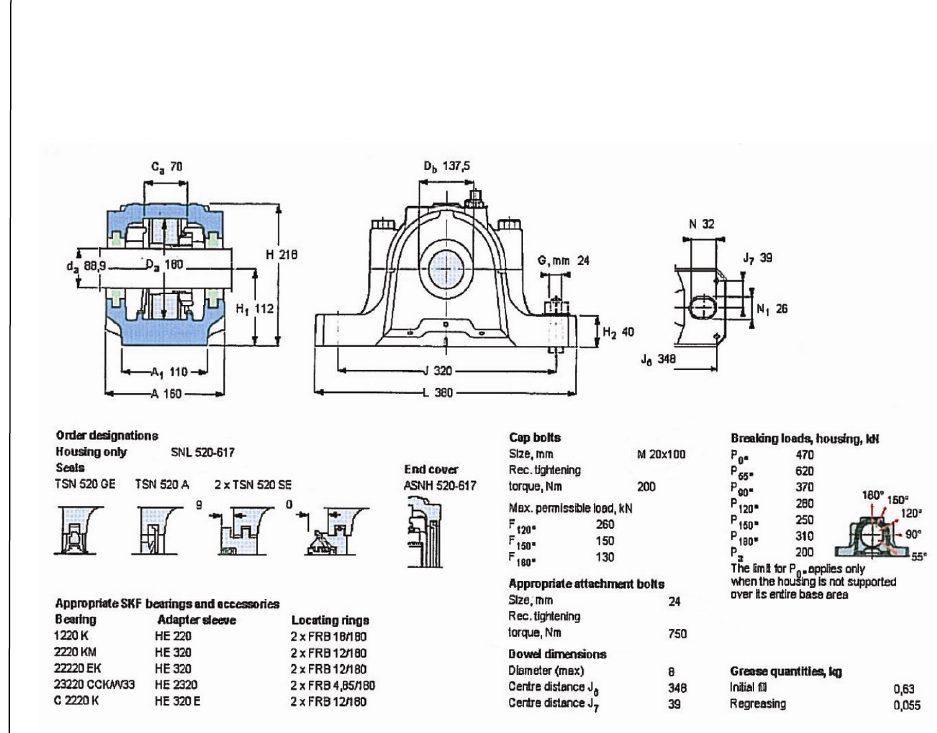
Figure 12 – Construction of the bearing housings SKF SN 520 and SKF SN